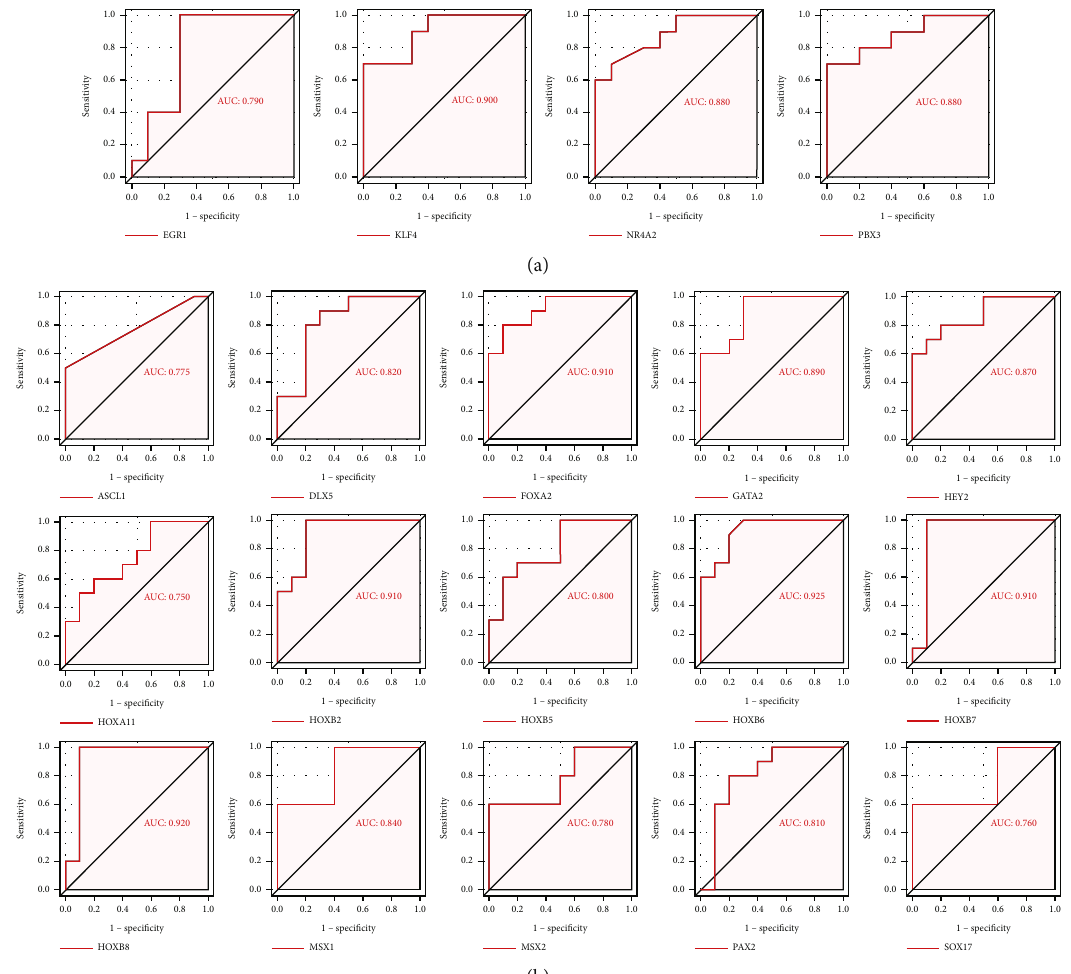
Figure 8: The ROC analysis of the hub IRGs predicting the severity of endometriosis. (a) ROC analysis of the upregulated DETFs predicting endometriosis severity in GSE51981. (b) ROC analysis of the downregulated DETFs predicting the severity of endometriosis in